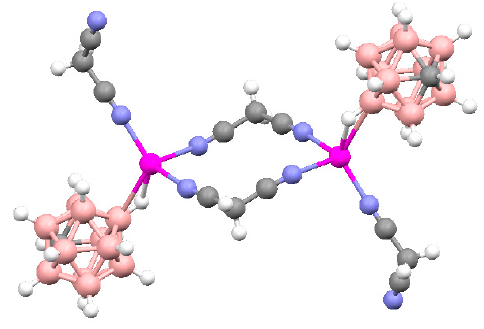
Figure 85. The X-ray structure of {Ag(NCCH 2 CN) 2 [CB 11 H 12 ]} 2 .